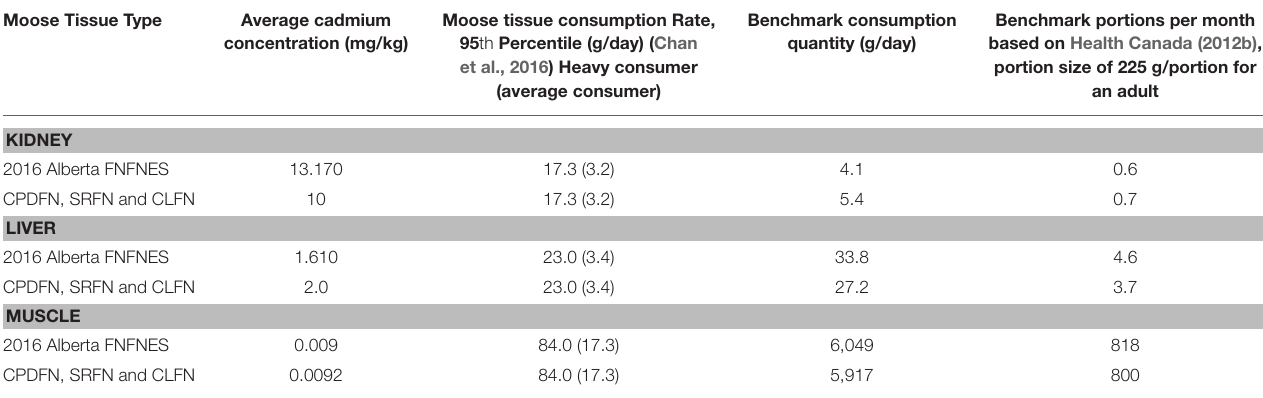
TABLE 9 | Summary of benchmark consumption quantities for an Adult. Moose Tissue